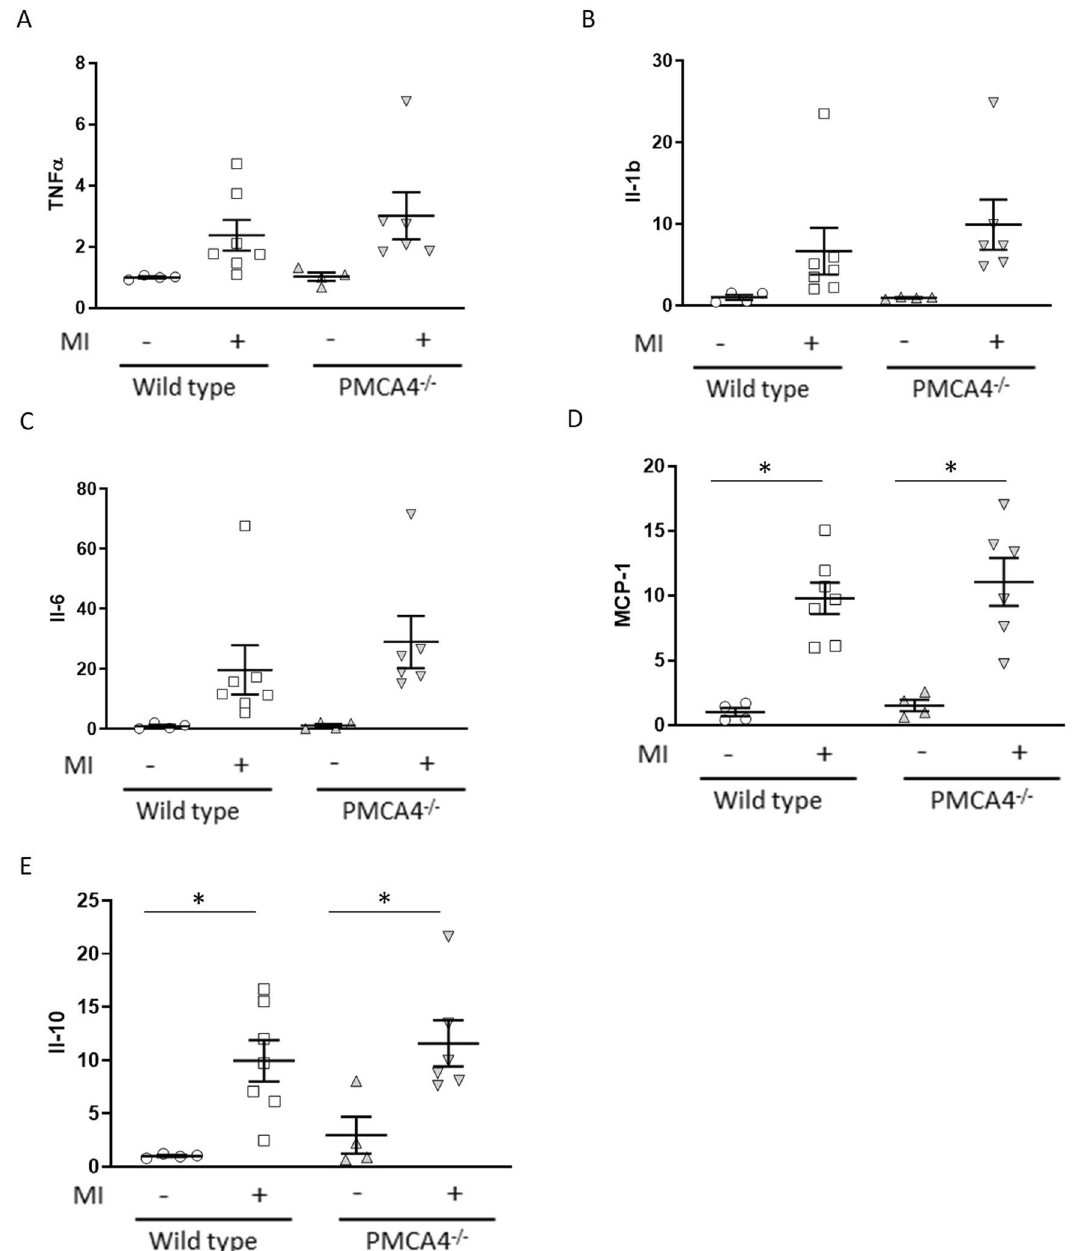
Figure 4. PMCA 4 global deletion does not affect the acute inflammatory response post-MI. Myocardial gene expression was examined by qRT-PCR in WT (clear points) and PMCA4 −/− (grey points) hearts 2 days post sham or MI surgery for pro-inflammatory mediators ( A ) TNFα, ( B ) Interleukin-1β, ( C ) Interleukin-6 and ( D ) MCP-1, in addition to anti-inflammatory cytokine ( E ) Il-10 Shams n = 4, WT MI n = 7, PMCA4 −/− MI n = 6. * p <